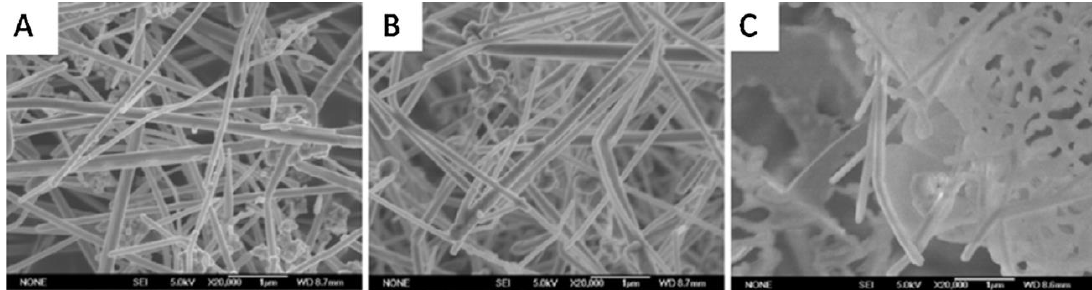
Figure 10. SEM images of CuNW ( A ) composite PCM with 58.9 w.t% ( B ) and 1.32 wt.% ( C ) of CuNWs [64].